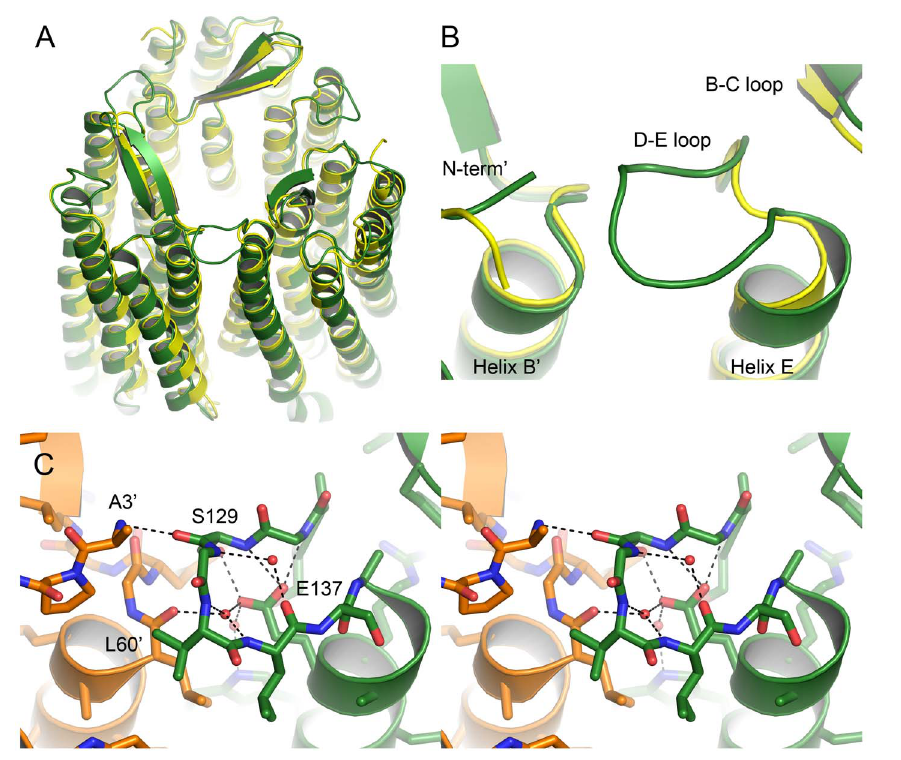
Figure 7. Structure of the Hm BRI trimer and its D-E loop. (A) Comparison of the Hm BRI trimer structure (green) with that of Hs BR [23] (yellow). Hm BRI trimer aligns well in the extracellular region, but the protomers are slightly rotated at the cytoplasmic side. (B) Magnification of the D-E loop. Unlike in other trimerizing retinylidene proteins, in Hm BRI the loop is extended and makes contact to the adjacent protomer. (C) Wall- eyed stereogram of the Hm BRI D-E loop. The adjacent protomer is shown in orange and its residues are marked by a prime. Three structural water molecules are observed that stabilize the loop